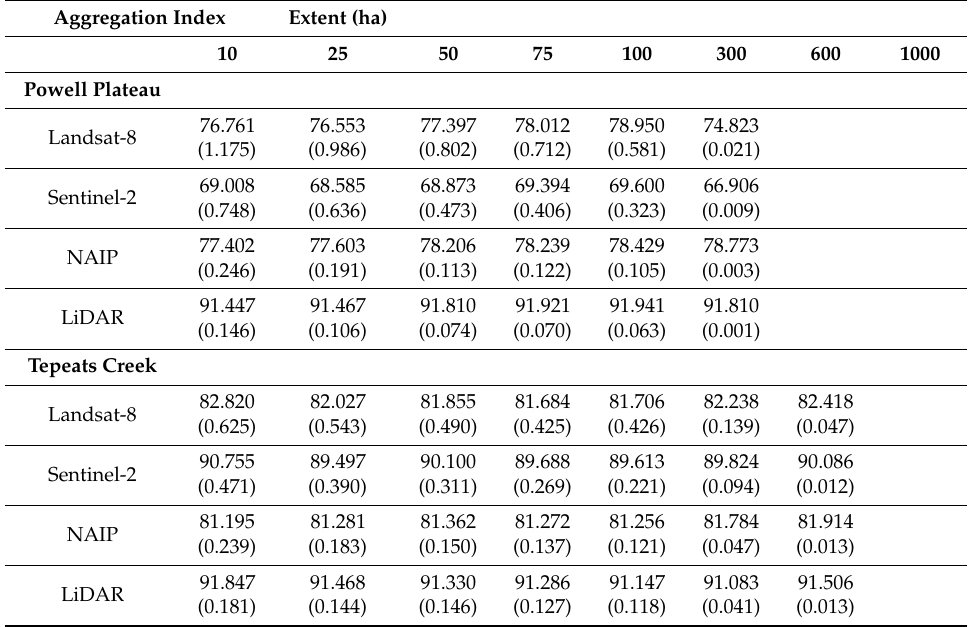
Figure 6. Violin plots (colored by extent and depicting probability density of the data at different values smoothed by a kernel density estimator), box-and-whisker plots (black and white) and mean (red dot) for aggregation index (0–100). Aggregation index indicates how adjacent patches of canopy cover are to each other for each landscape and data product (Landsat-8 30 m, Sentinel-2 10 m, NAIP 1 m, LiDAR 1 m), and across multiple spatial extents. Insets with rescaled y-axis provided for clarity. Table 5. Aggregation index (AI) (%) of canopy cover across each landscape and data product (Landsat-8 30 m, Sentinel-2 10 m, NAIP 1 m, LiDAR 1 m), and across multiple spatial extents. Mean values and standard error (SE) are shown.